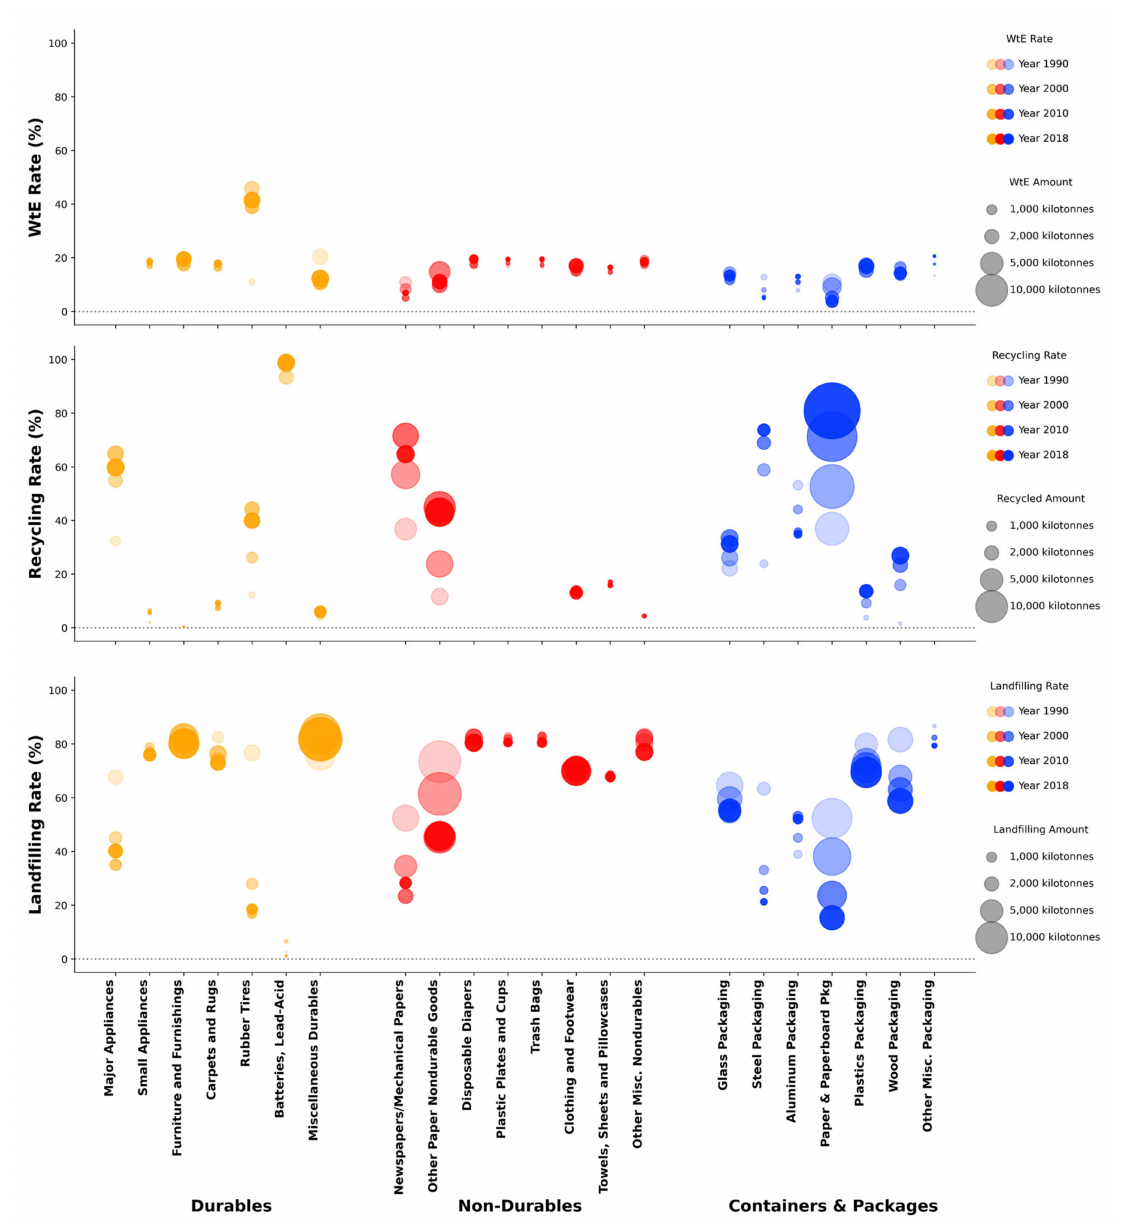
Figure 4. Recycling, energy recovery, and landfilling rates of products managed in the US in 1990, 2000, 2010 to 2018. Bubble size represents the amount of products recycled, combusted for energy, and